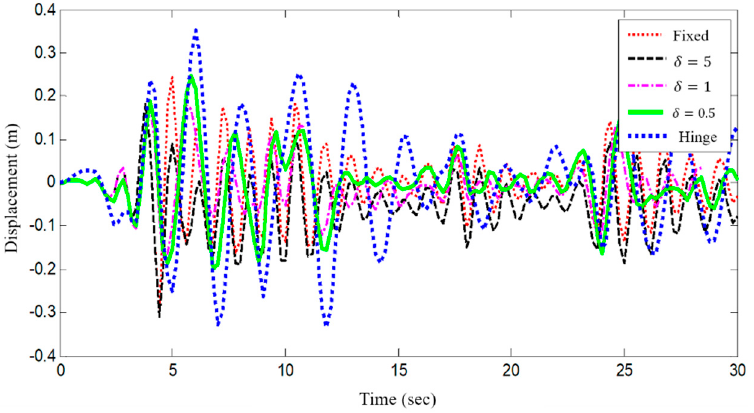
Figure 9. Time history of displacement.